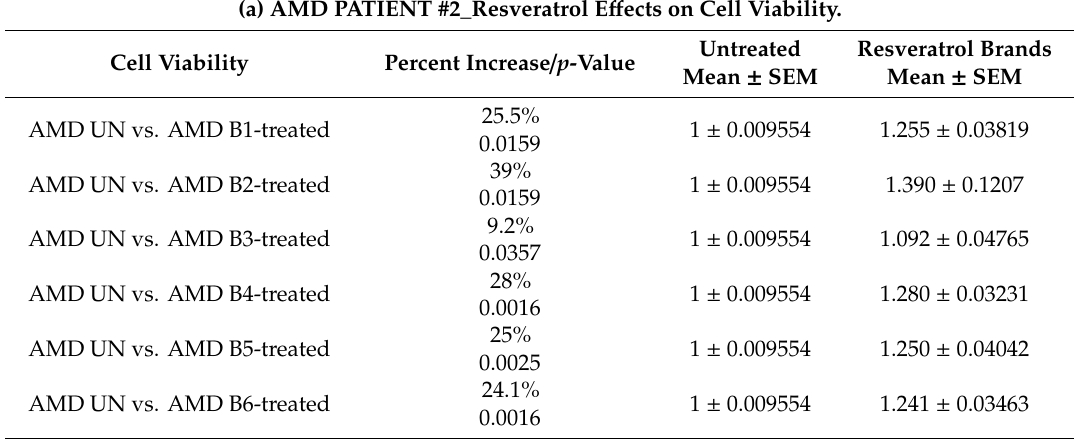
Table 4. E ff ects of resveratrol formulations on cell viability ( a ) and ROS levels ( b ) in AMD patient #